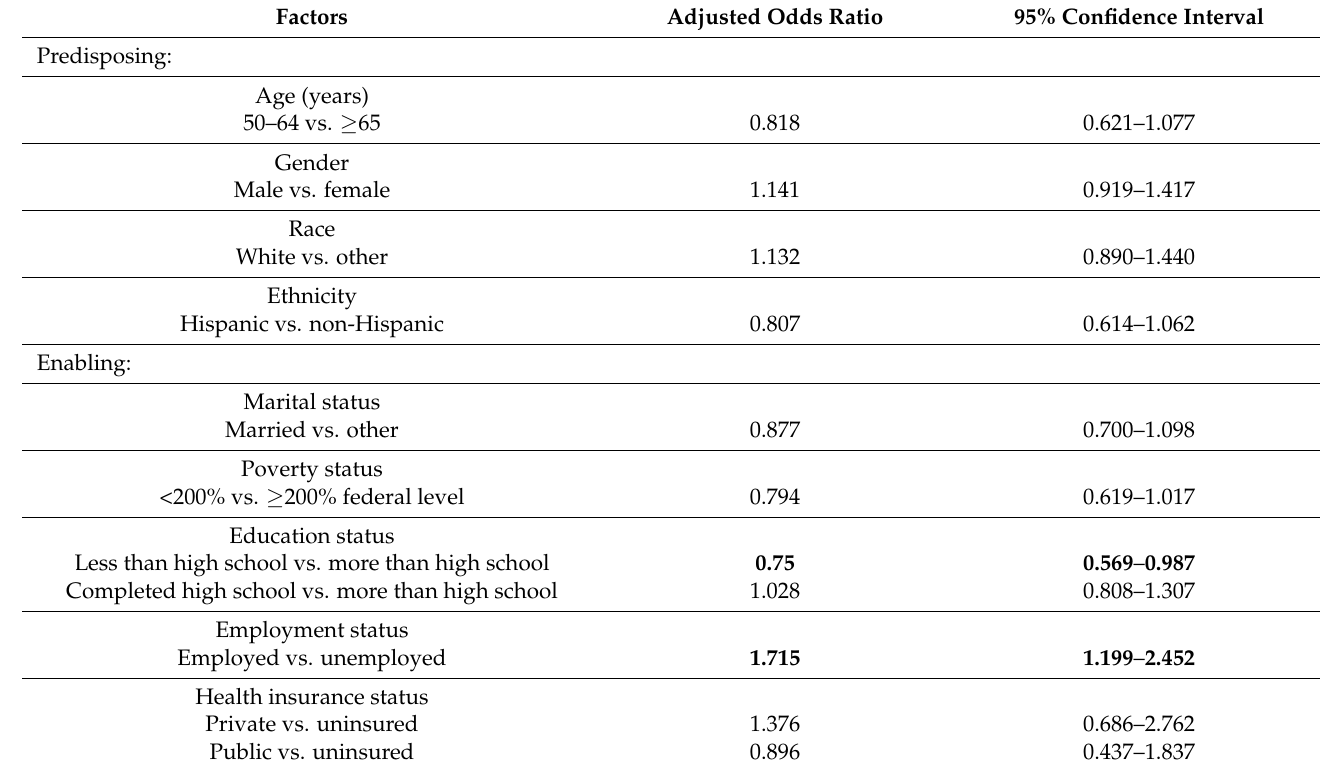
Table 2. Predictors of good perceived mental health status among older United States adults (age ≥ 50 years) with self-reported pain in the past four